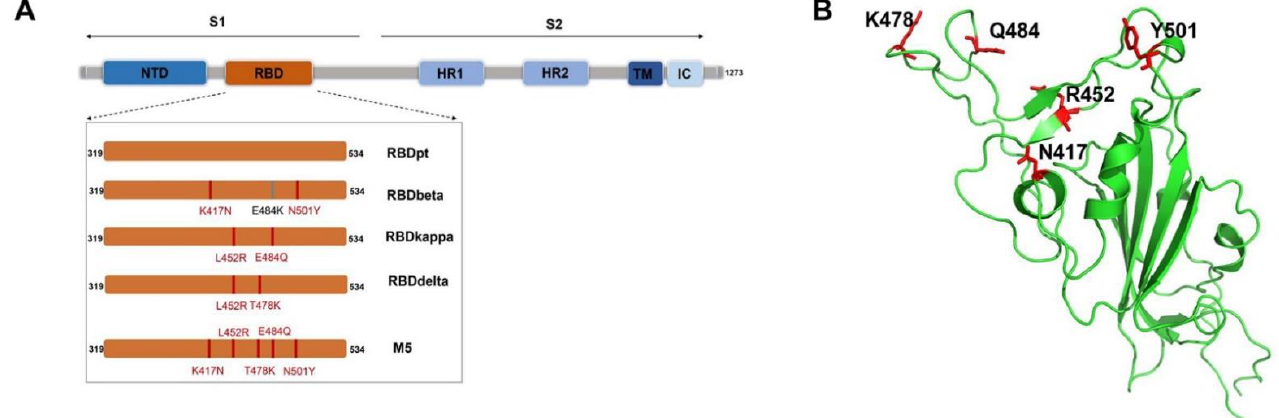
Figure 1. Design of the RBD5m protein. ( A ) Schematic illustration of the RBD5m design. The mutant sites of the receptor-binding domains (RBDs) of the SARS-CoV-2 Beta (RBDbeta), Kappa (RBDkappa), and Delta (RBDdelta) variants are marked in red or gray. In the RBDs of the SARS-CoV-2 variants, the amino acid sites overlapping with the RBD5m protein mutation sites are marked in red and the non-overlapping sites are displayed in gray. ( B ) Structure of RBD5m, as predicted by the PyMol simulation. The five amino acid sites of RBD5m that differ from RBDpt are highlighted in